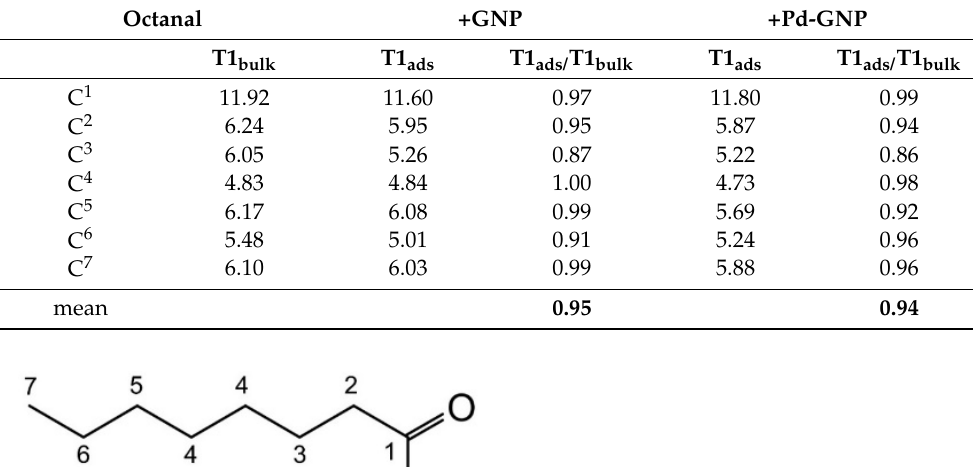
Table 5. Octanal in p -Xylene-d 10 : T1 bulk and T1 ads resulting from analysis of the inversion recovery Figure 6. Different adsorption modes of benzaldehyde on Pd/C catalyst. curves (Figures S4–S6) from 13 C NMR spectra in high-field (600 MHz).